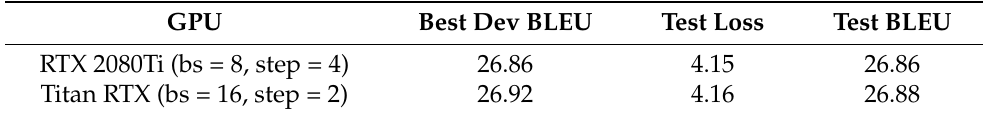
Table 3. The best Dev BLEU and the Test Loss and BLEU on two